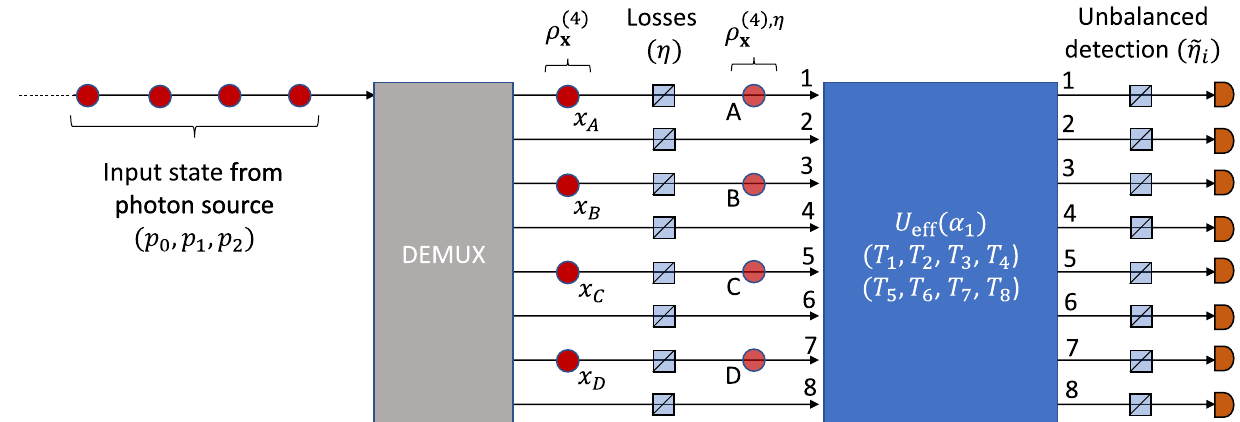
FIG. 12. Schematic and synoptic view on the parameters involved to model the action of multiphoton emission, circuit errors, losses, and unbalanced detection on the performed experiment to retrieve indistinguishability c 1 . The modeling of each noise contribution and their respective relevant parameters are detailed in the text of Appendix H. The estimated values c mod 1 turning on successive noise contributions in the model are given in Table IV which also specifies the values of the parameters used in each